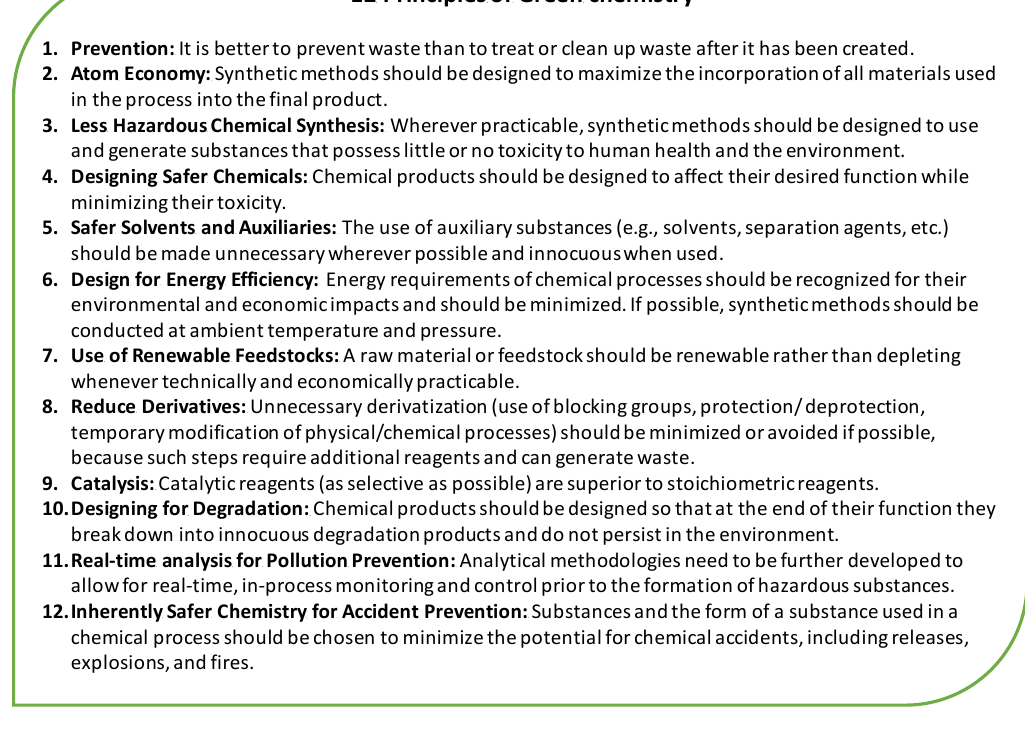
Figure 2. The 12 Principles of Green Chemistry. Anastas, P. T.; Warner, J. C. Green Chemistry: Theory and Practice, Oxford University Press: New York, NY, USA, 1998; p. 30. By permission of Oxford University Press [23].